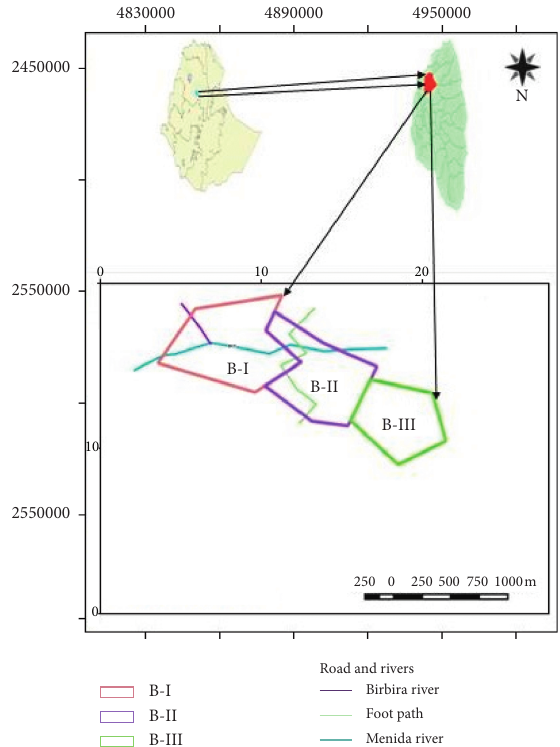
Figure 1: Map of Ethiopia, Amhara regional state, Yetefet Woyenat forest, and sample areas (B-I � block I; B-II � black II, and B- III � block